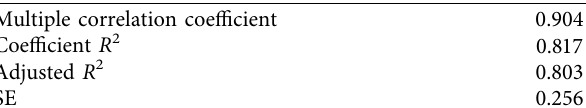
Table 9: Statistics for the regression model between observed pIC and predicted pIC 50 .